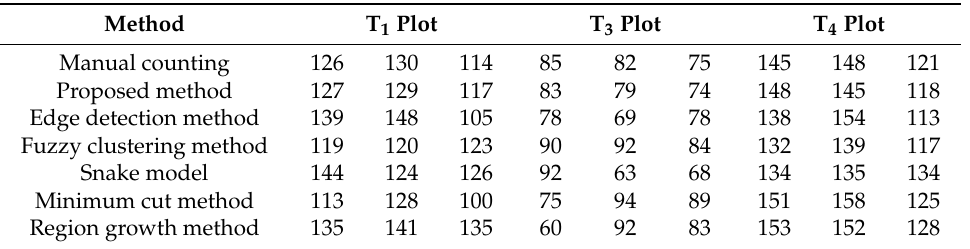
Table 4. Wheat ear recognition results with different coarse segmentation methods and manual counting